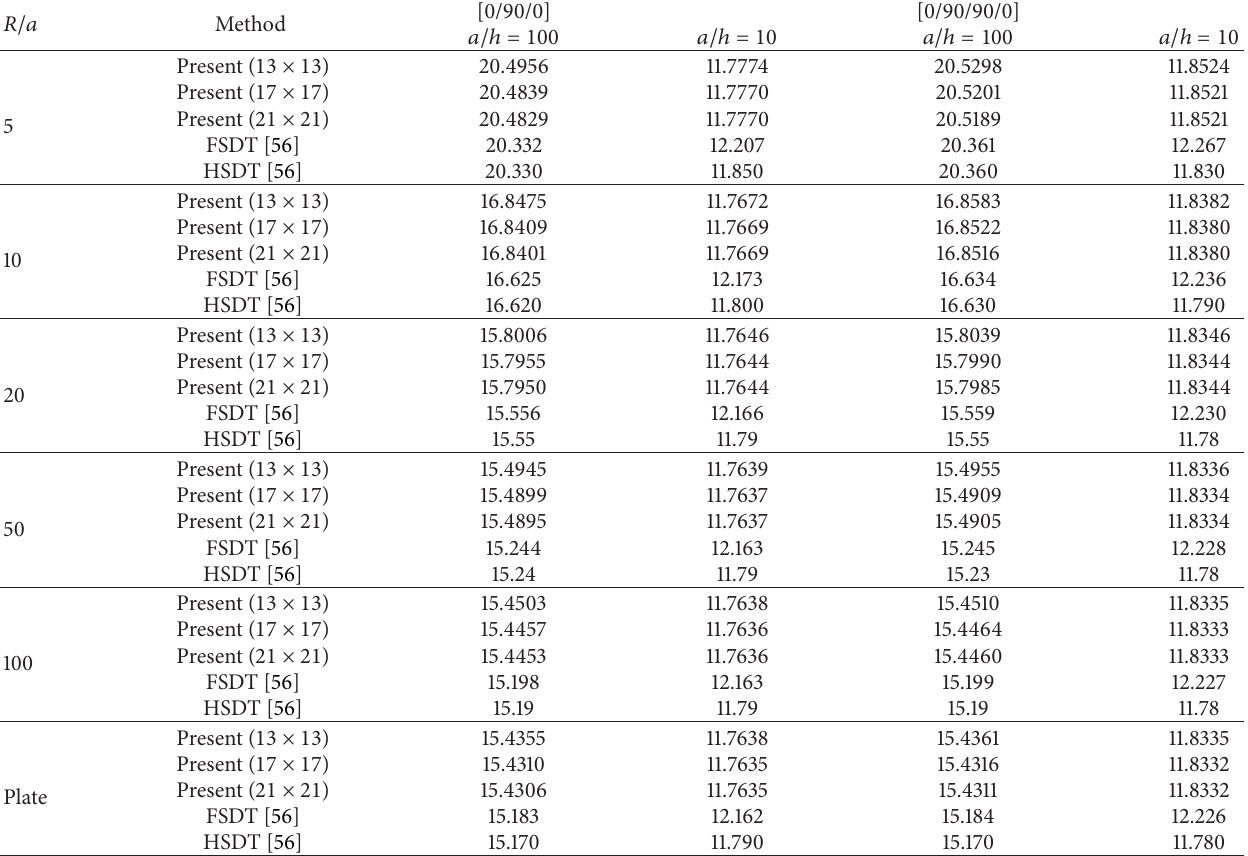
Table 4: Nondimensionalized fundamental frequencies of cross-ply cylindrical shells, 𝜔 = 𝜔(𝑎 2 /ℎ)√𝜌/𝐸 2 .